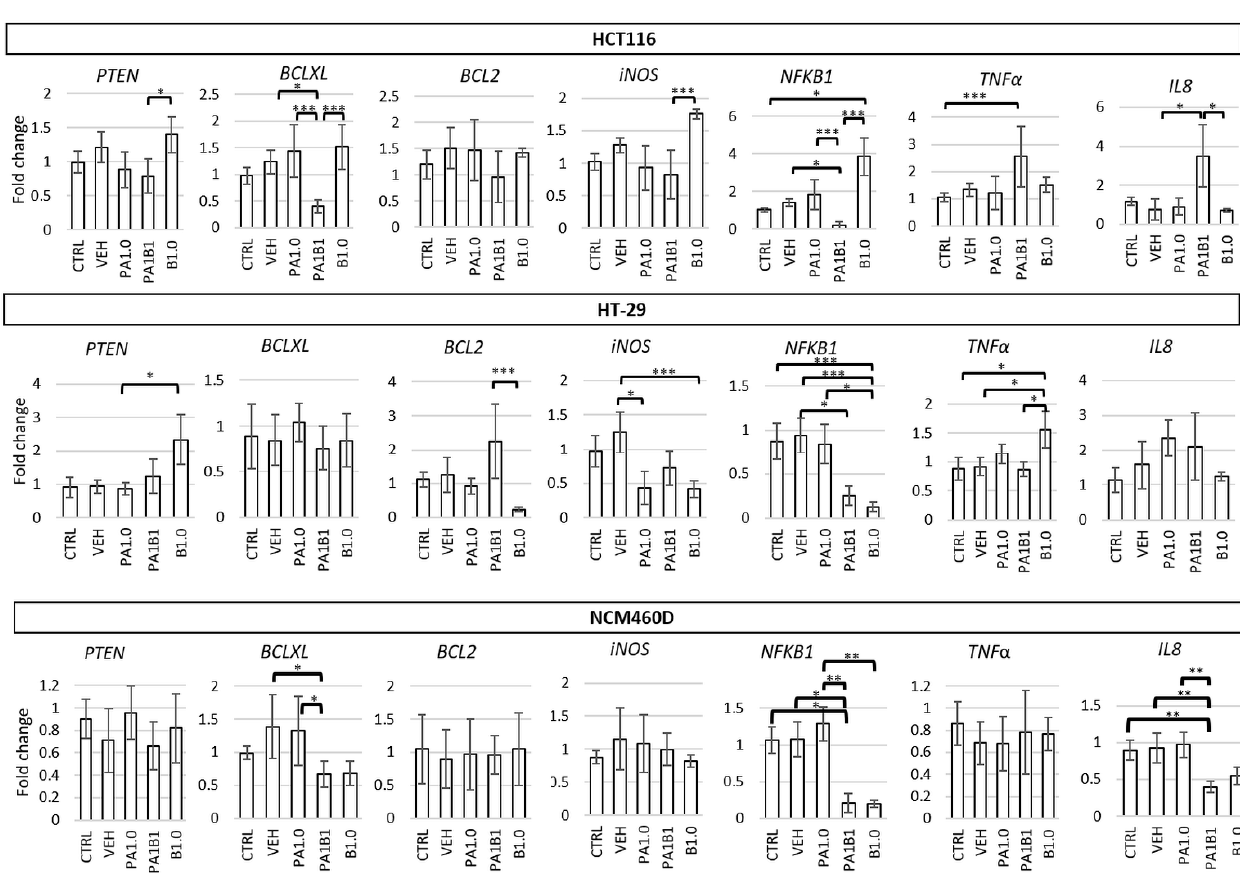
Figure 3. Impact of 1 mM butyrate (B1.0), 1 mM phytate (PA1.0) and their combination (PA1B1) on the expression of PTEN (phosphatase and tensin homolog), BCLXL (B-cell lymphoma—long isoform (Bcl-xL)) , BCL2 (B-cell lymphoma protein 2), iNOS (inducible nitric oxide synthase), NFKB1 (nuclear factor kappa B p105 subunit), TNF α (tumor necrosis factor alpha), and IL8 (interleukin 8) genes in HT116, HT-29, and NCM460D cells. The values are significantly different at p < 0.05, p < 0.01, and p < 0.001 are marked with *, **, and ***, respectively.